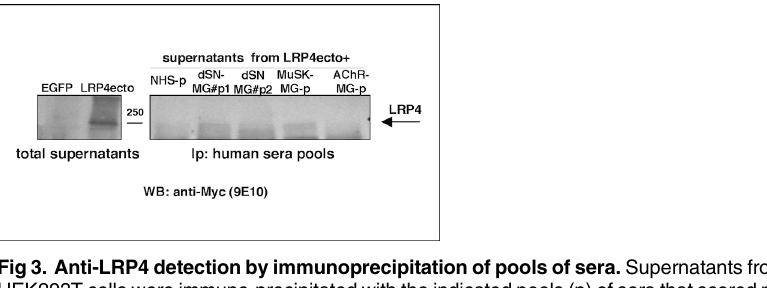
The whole MG population included 68 women and 33 men (ratio F:M: 2.06). The 14 LRP4 pos- itive (pos) patients showed an increased female preponderance, 11 women and 3 men, when compared to the 87 LRP4 negative (neg) patients, 57 women and 30 men: ratio F:M of 3.6 ver- sus 1,9. When MG patients are subdivided in early onset (EO), according to age of onset (cid:1) 50 years, and late onset (LO), the whole MG population included 71 EO and 30 LO (ratio EO:LO: 2.3). We found that the LRP4-pos patients were younger, 11 EO and 3 LO, when compared to the LRP4-neg patients, 60 EO and 27 LO: ratio EO:LO of 3.6 versus 2.22. Considering only the 55 dSN-MG group (Table 2), there were 39 women and 16 men (ratio F:M: 2.4). Among these, the 8 dSN/LRP4-pos patients displayed a female predominance including 7 women and 1 men while the 47 dSN/LRP4-neg patients included 32 women and 15 men: ratio F:M of 7 versus 2.1. Considering age at onset, the whole dSN-MG group included 41 EO and 14 LO (ratio EO:LO: 2.9). Also in this case we found that the 8 dSN/LRP4-pos patients Table 2. Clinical correlates with and without anti-LRP4 antibodies in double seronegative myasthenic patients. Double seronegative myasthenic patients LRP4-positive LRP4-negative Total (n°) (n°) (n°) Patients 8 47 55 Gender Female (F) 7 32 39 Males (M) 1 15 16 Age at onset Early (EO) 7 34 41 Late (LO) 1 13 14 Maximum MGFA I, IIA, IIB 6 22 28 IIIA, IIIB, IVA Current